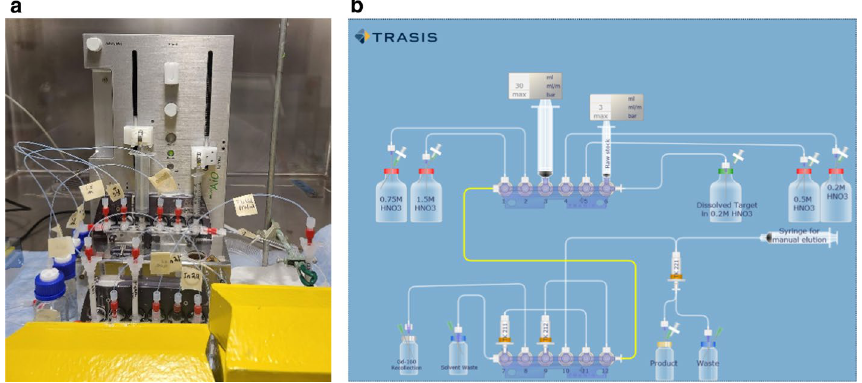
Fig. 4 TRASIS Mini AIO module and components set-up within hotcell ( a ), TRASIS layout diagram ( b